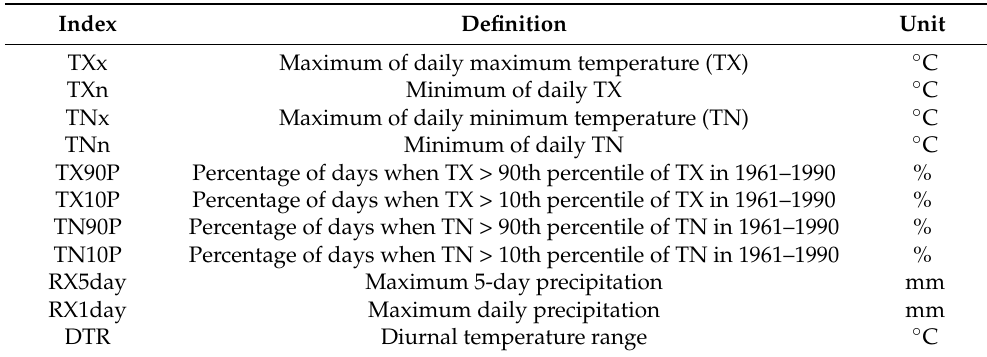
Table 3. Calculated extreme indices